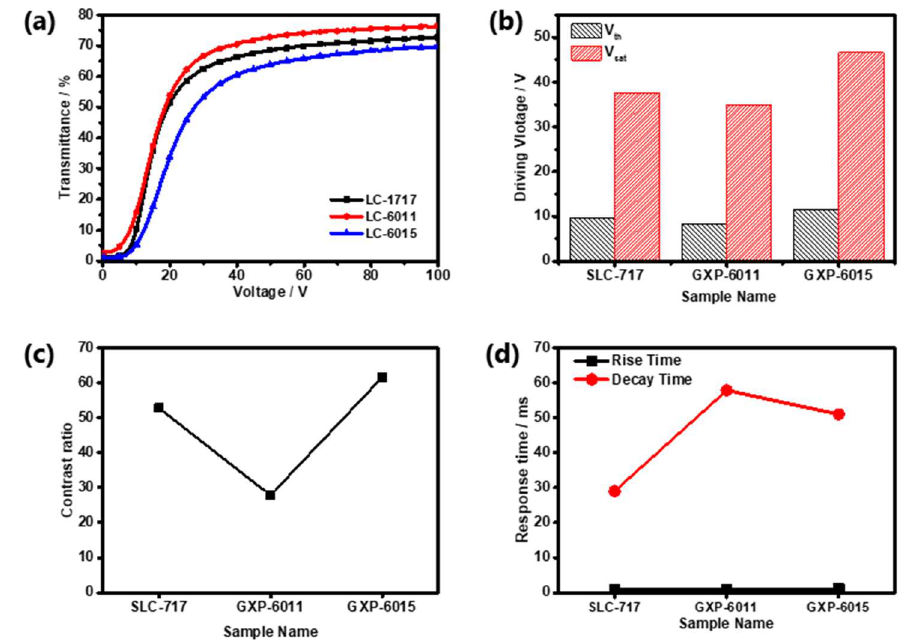
Figure 4. ( a ) Transmittance as a function of applied voltage (at 100 Hz frequency); ( b ) bar graph for threshold voltages ( V th ) and saturations voltage ( V sat ); ( c ) contrast ratio ( CR ) and ( d ) response time of Samples B1–B3.